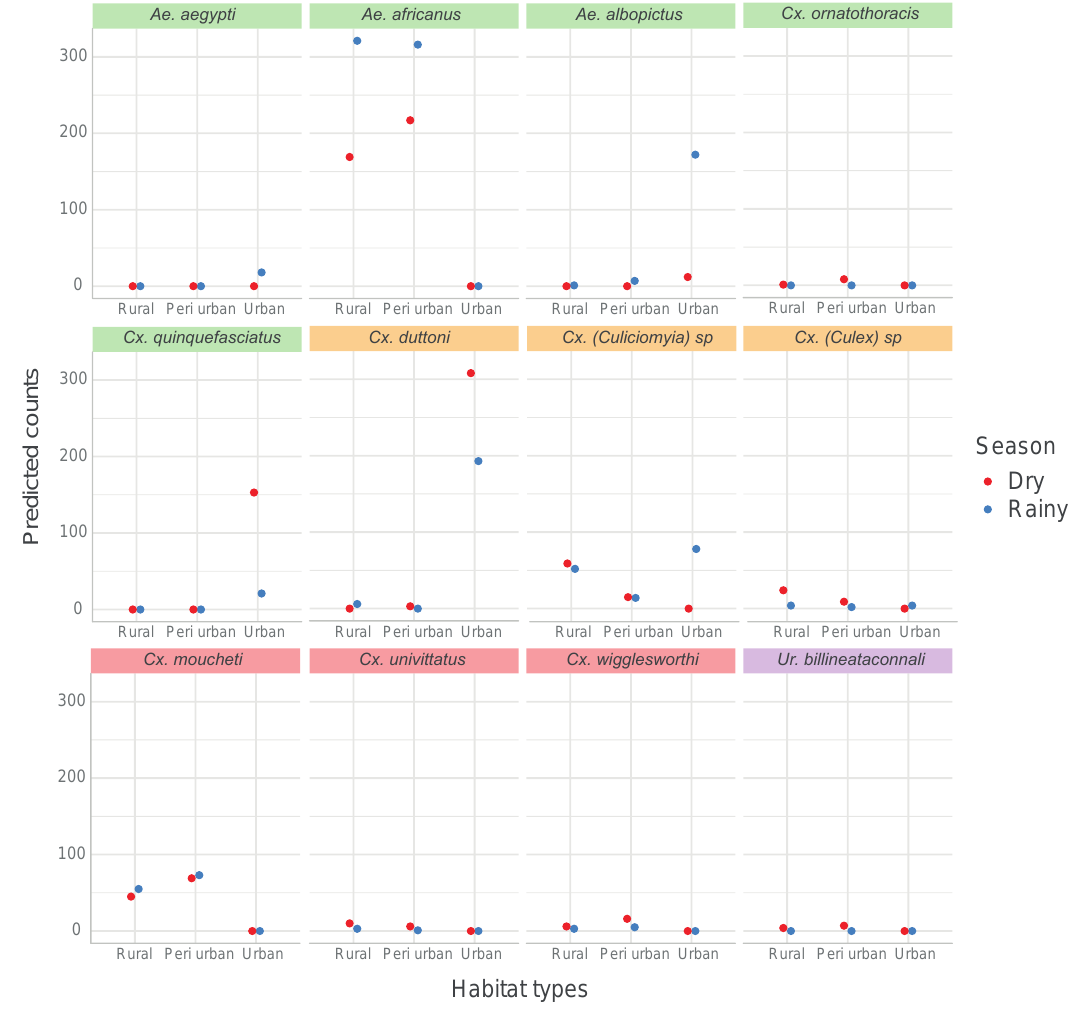
Figure 7. Interaction plot of predicted mosquito species abundance across habitat types and season. Green panel header: mosquito species with significant habitat types and season effects. Orange panel header: mosquito species with significant habitat types:season interaction. Pink panel header: mosquito species with significant habitat types effect only. Purple panel header: mosquito species with a significant season effect only.